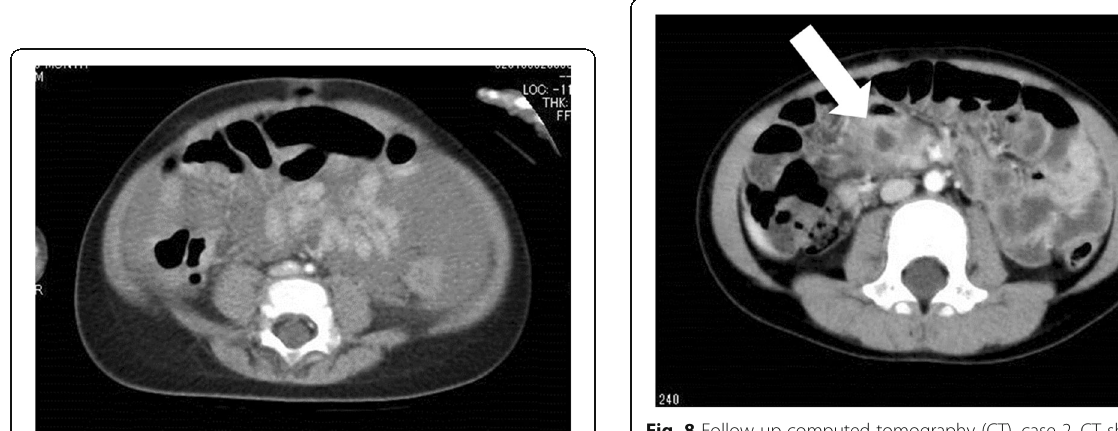
Fig. 8 Follow-up computed tomography (CT), case 2. CT shows the remaining duplication cyst around the end of the ileum (white